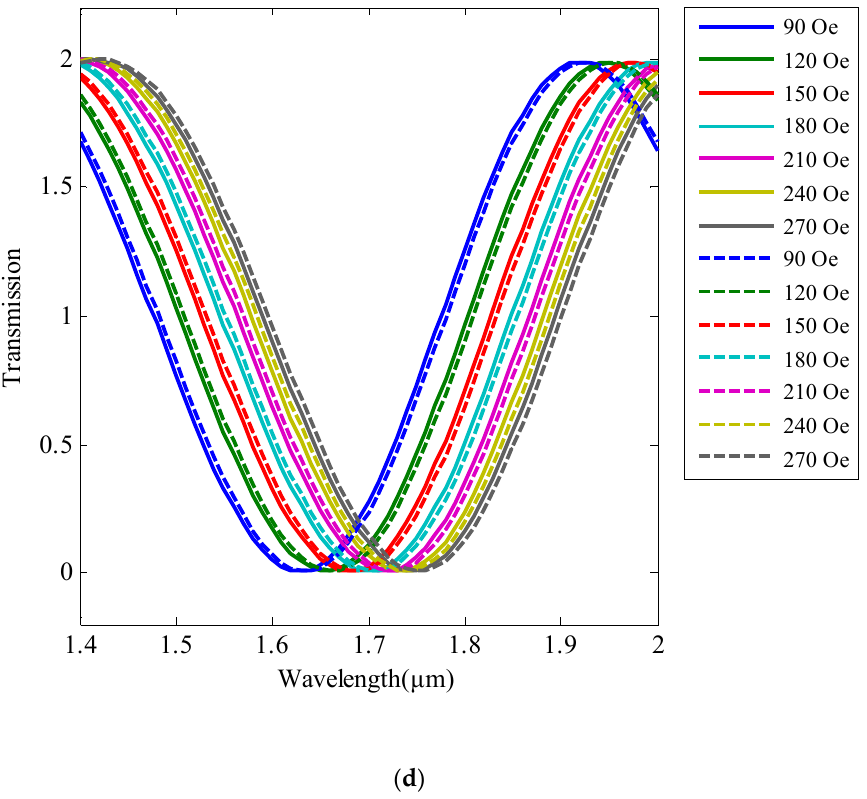
Figure 8. The total transmission spectra of dual-core PCF with different structure parameters. ( a ) Transmission spectra with different d = 0.84 (solid curve) and 1.05 (dashed curve), ( b ) transmission spectra with different Λ = 2.1 (solid curve) and 2.3 (dashed curve), ( c ) transmission spectra with different η c = 0.5 (solid curve) and 0.6 (dashed curve), and ( d ) transmission spectra with different η = 0.6 (solid curve) and 0.7 (dashed curve).